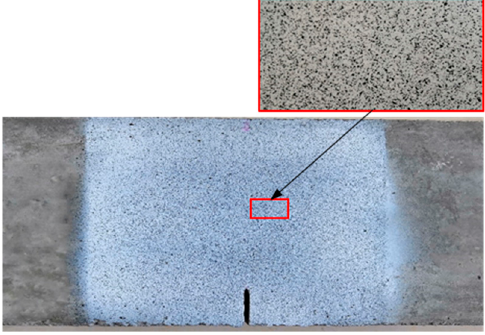
Figure 4. Matte speckle pattern on the measuring surface of the test beam.